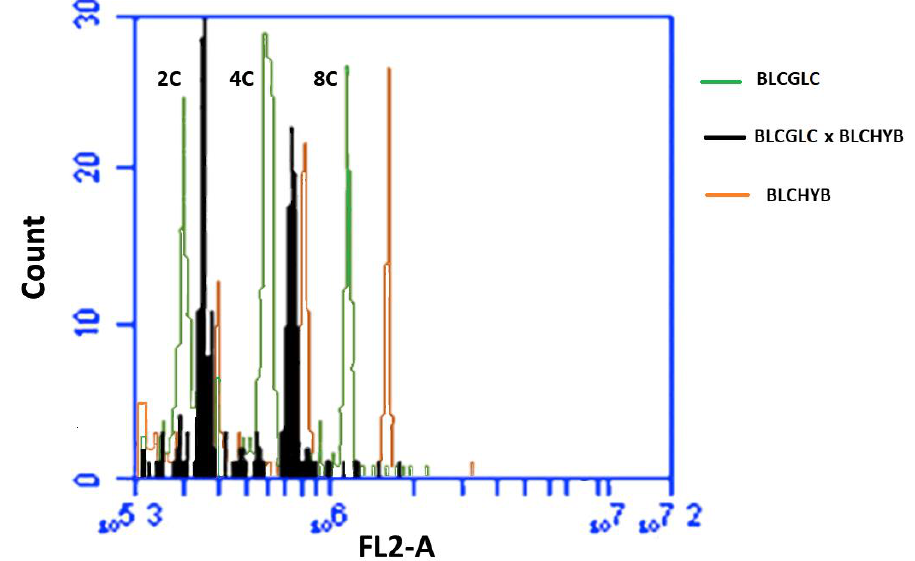
Figure 4. Comparison of the 2C, 4C and 8C peaks channels between Blc. Haw Yuan Beauty (BLCHYB) (orange line), Blc. Goldenzelle “LC” (BLCGLC) (green line) and the progeny of Blc. Haw Yuan Beauty × Blc. Goldenzelle “LC” not treated with colchicine (black line).